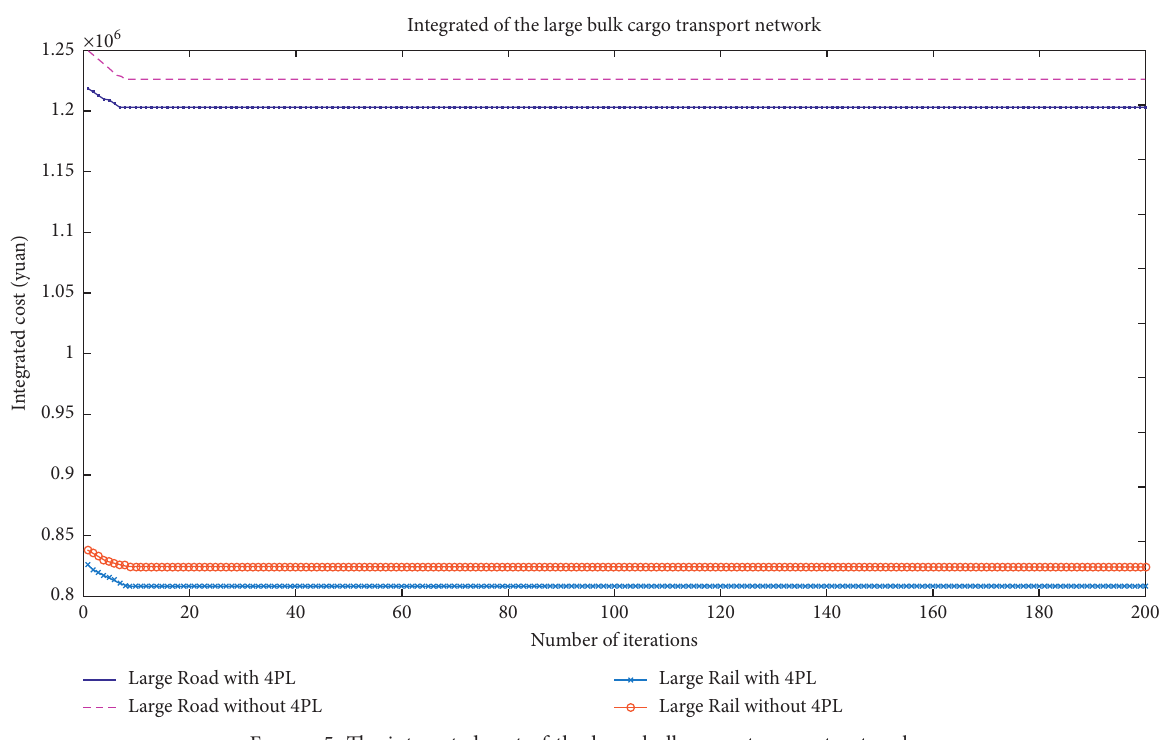
Figure 5: The integrated cost of the large bulk cargo transport Table 12: The flow of supply and demand points in the large bulk cargo transport network.